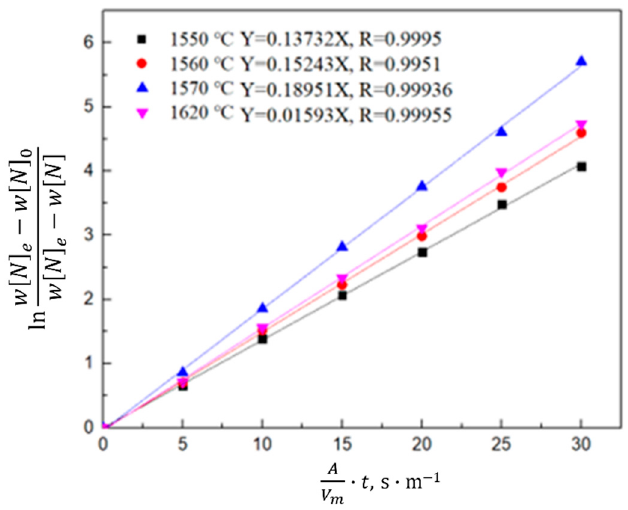
Figure 9. Kinetics of the nitrogen amount in the molten steel at different temperatures.